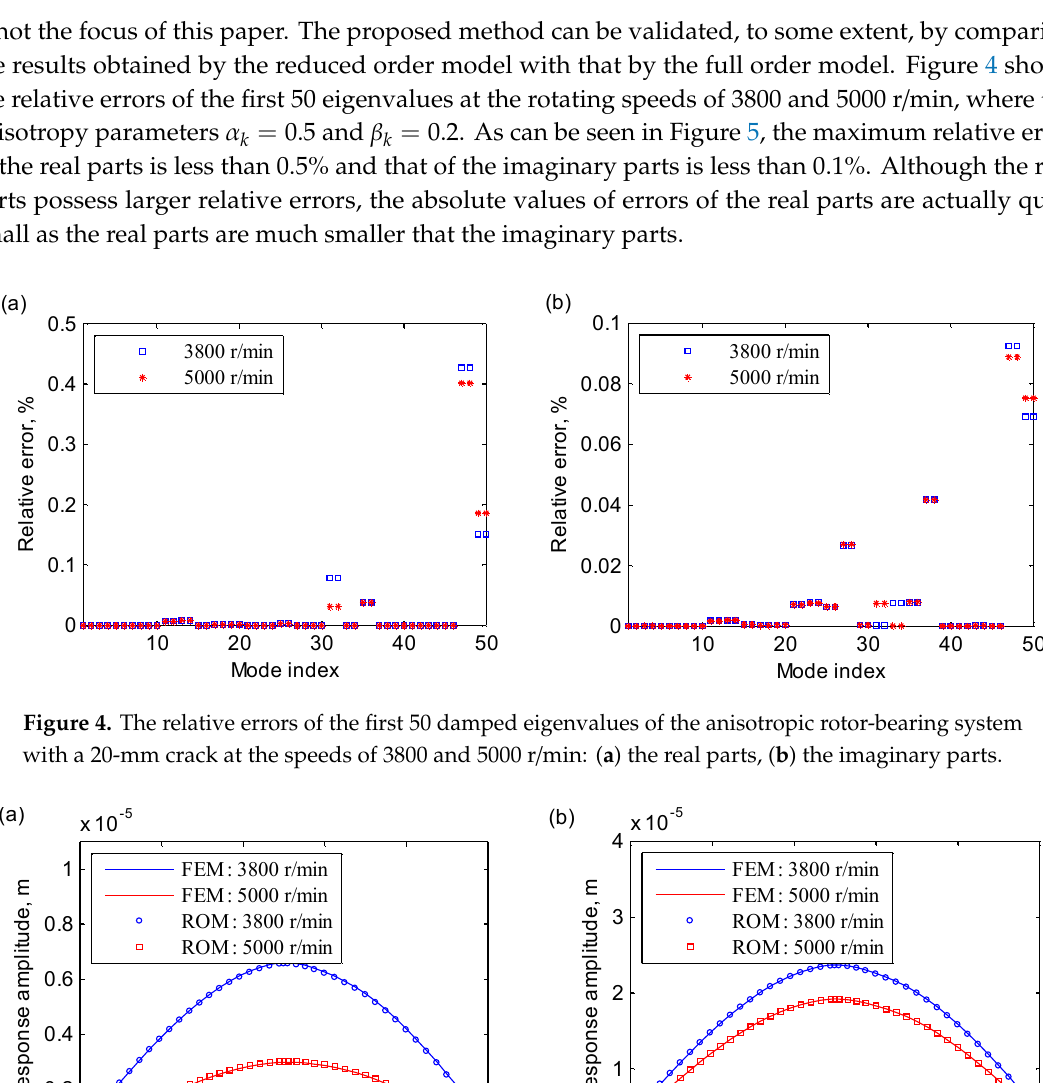
. Figure 3. The finite element model of a cracked rotor-bearing system. The first 60 eigenvectors are retained during model order reduction, as the 60th natural frequency has been much larger than the excitation frequencies. The retained harmonics in truncating Equations (21) and (27) is [ 7,7] h ∈ −